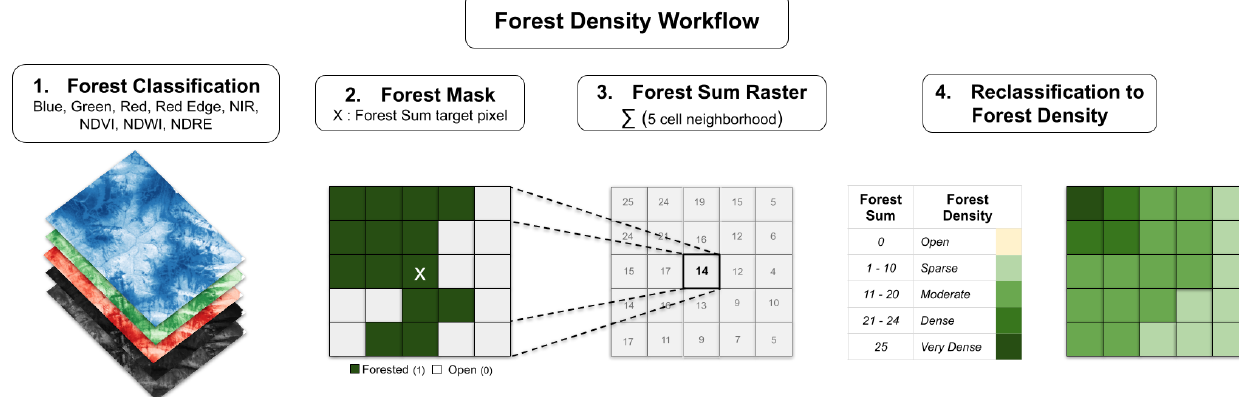
Figure 4. Forest density layer processing workflow.